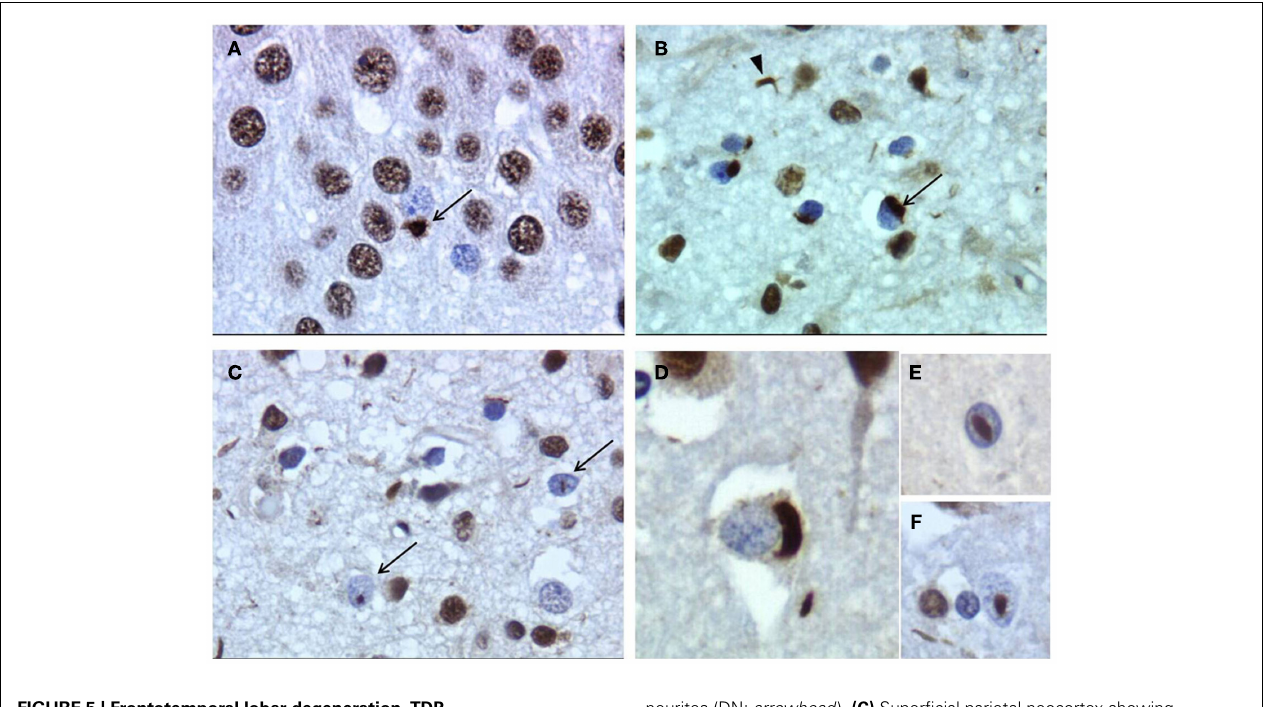
FIGURE 5 | Frontotemporal lobar degeneration–TDP neuropathology of patient with progranulin gene mutation. (A) Neuronal cytoplasmatic inclusion (NCI) in the hippocampus ( arrow ). (B) Superficial frontal neocortex showing NCIs ( arrow ) and dystrophic